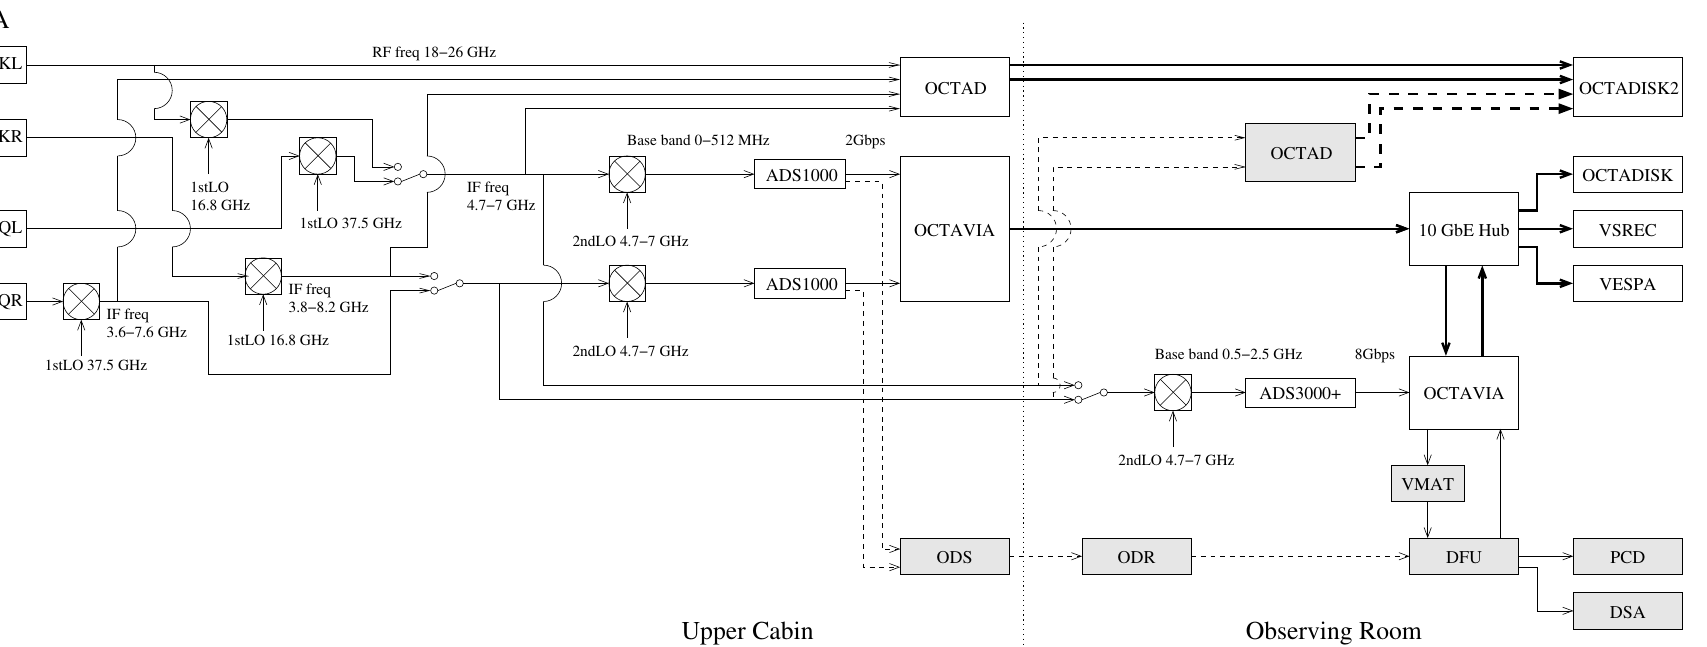
Figure 2. Schematic diagram of the front-end part of the 22 GHz and 43 GHz receivers (beam-A) on the 20 m telescopes of VERA. The two-letter receiver abbreviations encode frequency band in the first letter (K for 22 GHz, Q for 43 GHz) and polarization in the second letter. Signal paths follow the arrows. The 22 GHz radio frequency (RF) signals (18–26 GHz) are directly converted to intermediate frequency (IF) signals (4.7–7 GHz) using a “direct” sampler OCTAD. The 43 GHz RF signals are converted via the frequency down-converter to IF